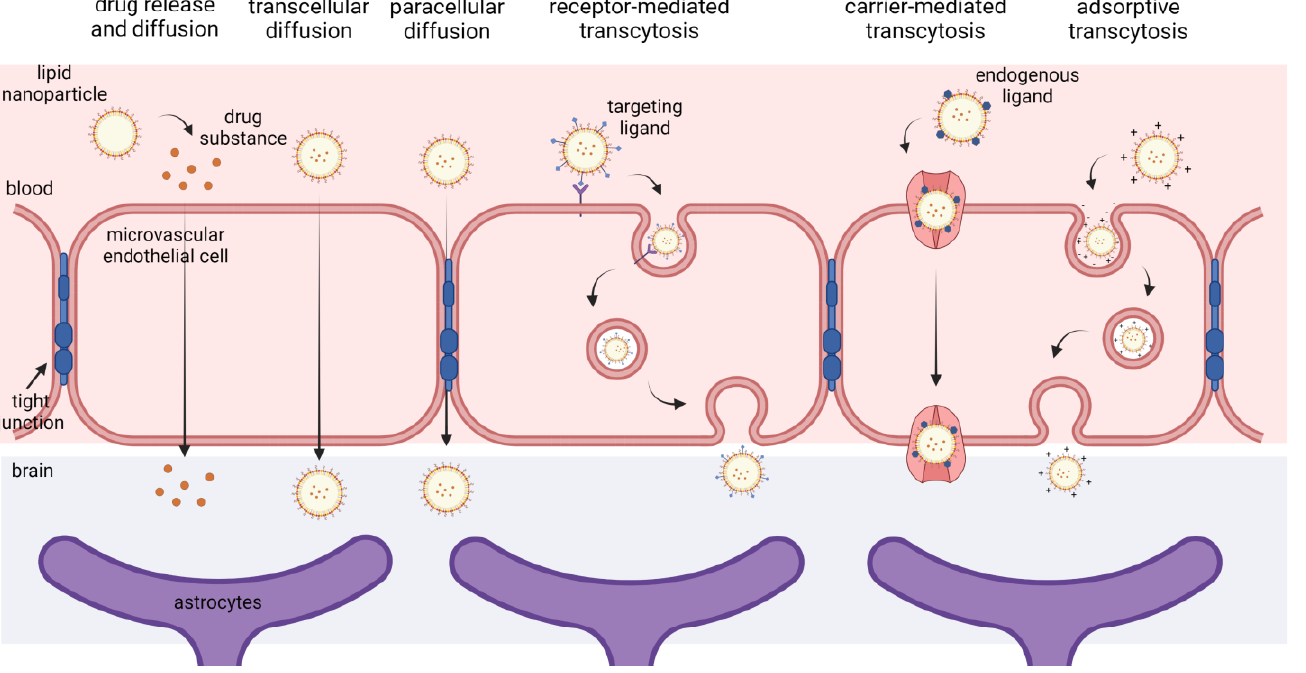
Figure 3. Proposed drug-delivery mechanisms across BBB in interaction with lipid nanoparticles [5,10,54,140]. Created with BioRender.com (accessed on 16 February 2022).